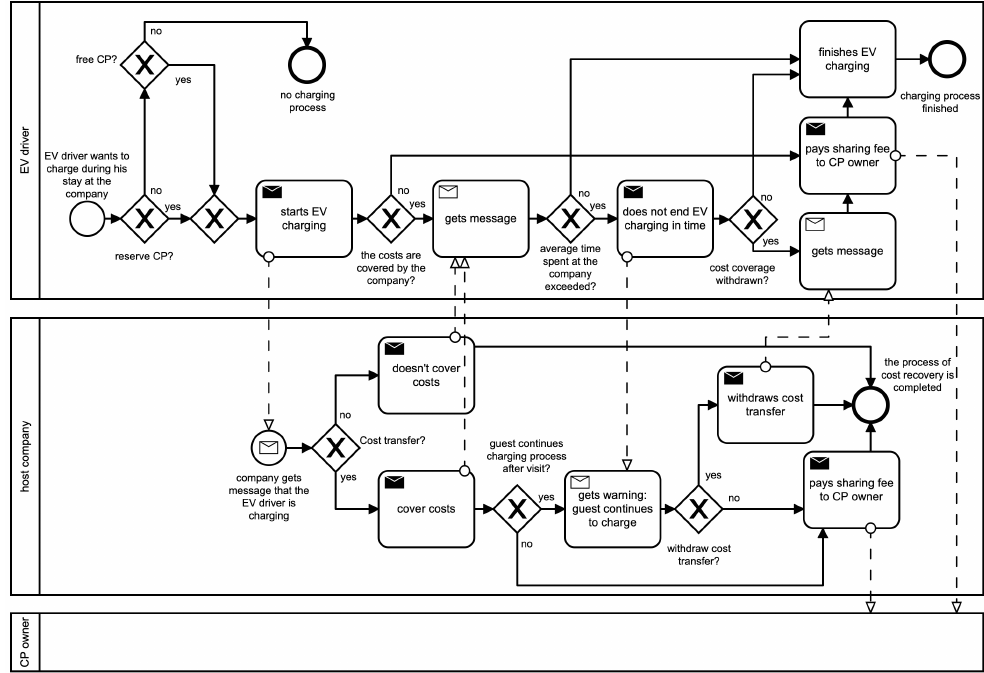
Figure 3. Example process: An external guest EV driver uses a pooled charging